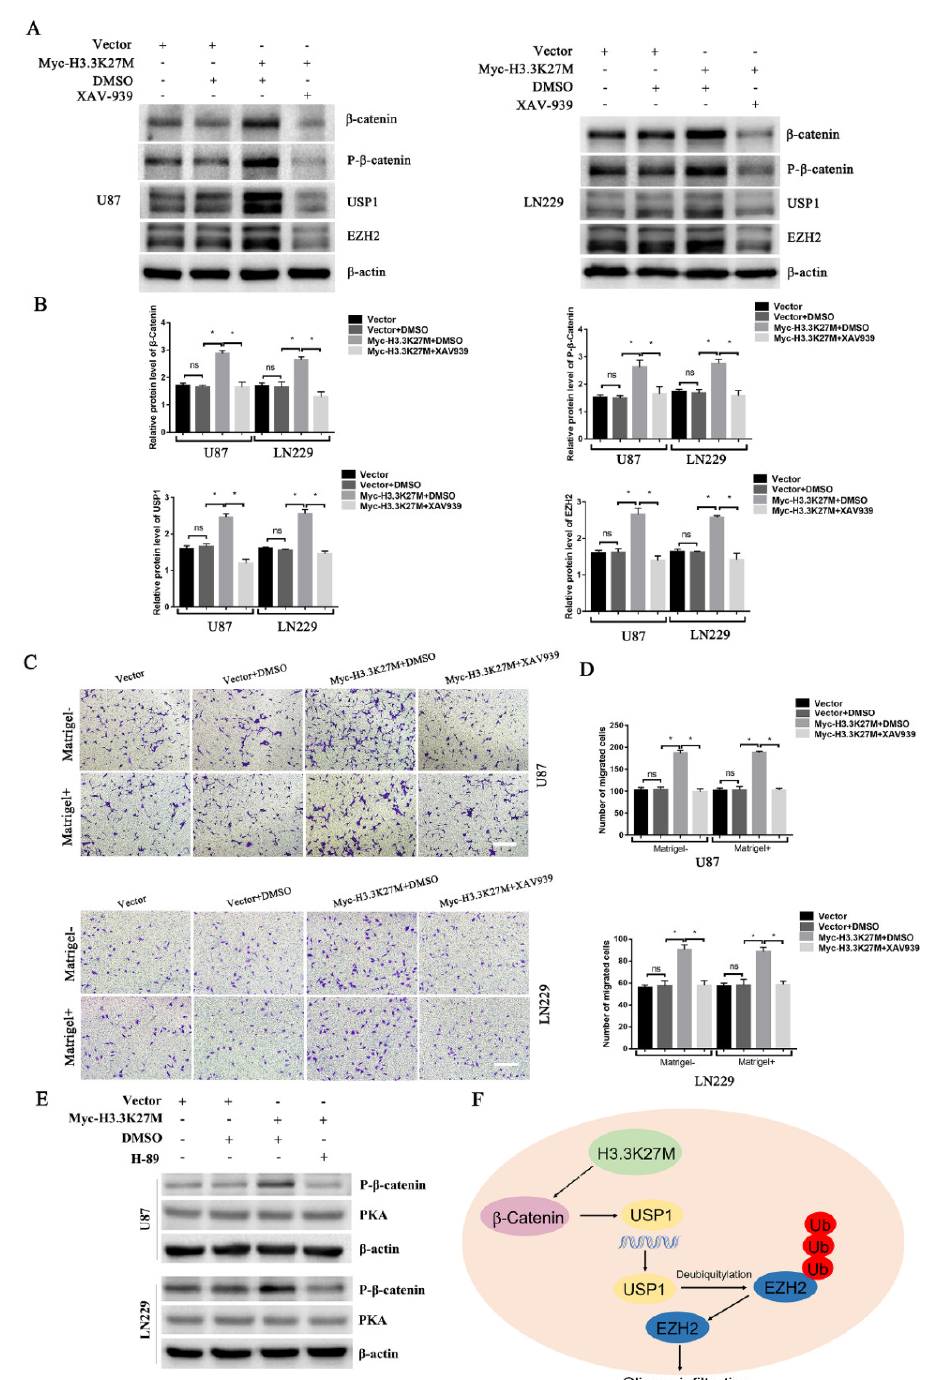
Figure 6. Western blotting and transwell assays showed that XAV-939 blocked the H3.3K27M-induced upregulation of β -catenin/USP1/EZH2 signaling and promotion of migration and invasion. Representative blots ( A ) and histograms ( B ) of β -catenin, P- β -catenin, USP1 and EZH2 levels after XAV-939 addition in U87 and LN229 cells. Representative images ( C ) and statistical graph ( D ) of transwell migration and invasion results after XAV-939 treatment of U87 and LN229 cells. The vehicle DMSO had no obvious effect on the signaling pathway. The concentration of XAV-939 was 20 µ M for 48 h. ( E ) Western blotting assays showed that the PKA inhibitor H-89 blocks the H3.3K27M-induced increase in β -catenin (Ser675) phosphorylation. ( F ) Schematic model illustrating the role of H3.3K27M in glioma tumor development. * p < 0.05; ns indicates no statistical